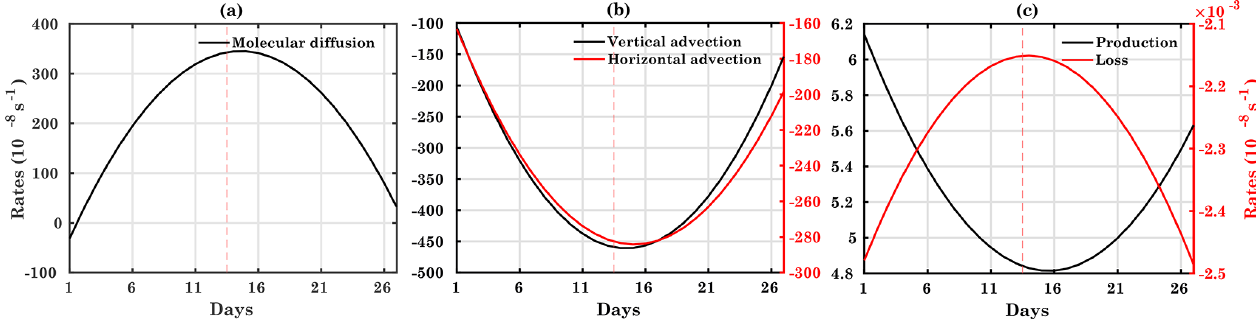
Figure 1. Time series of different terms: (a) molecular diffusion, (b) horizontal advection and vertical advection, and (c) production and loss for atomic oxygen mass mixing ratio. Both the y axes are marked with the corresponding color. The vertical dashed red line represents the middle of the 13th model day. All the parameters are plotted for pressure level 12 (260km) for noontime at 40 ◦ N, 18 ◦ E.